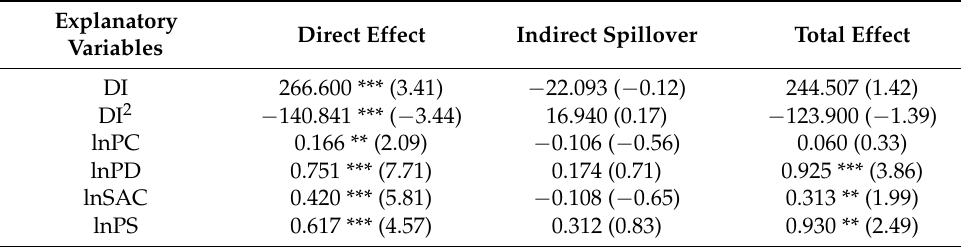
Table 7. Decomposition of the SDM model spatial spillover effects based on a geographic distance weight